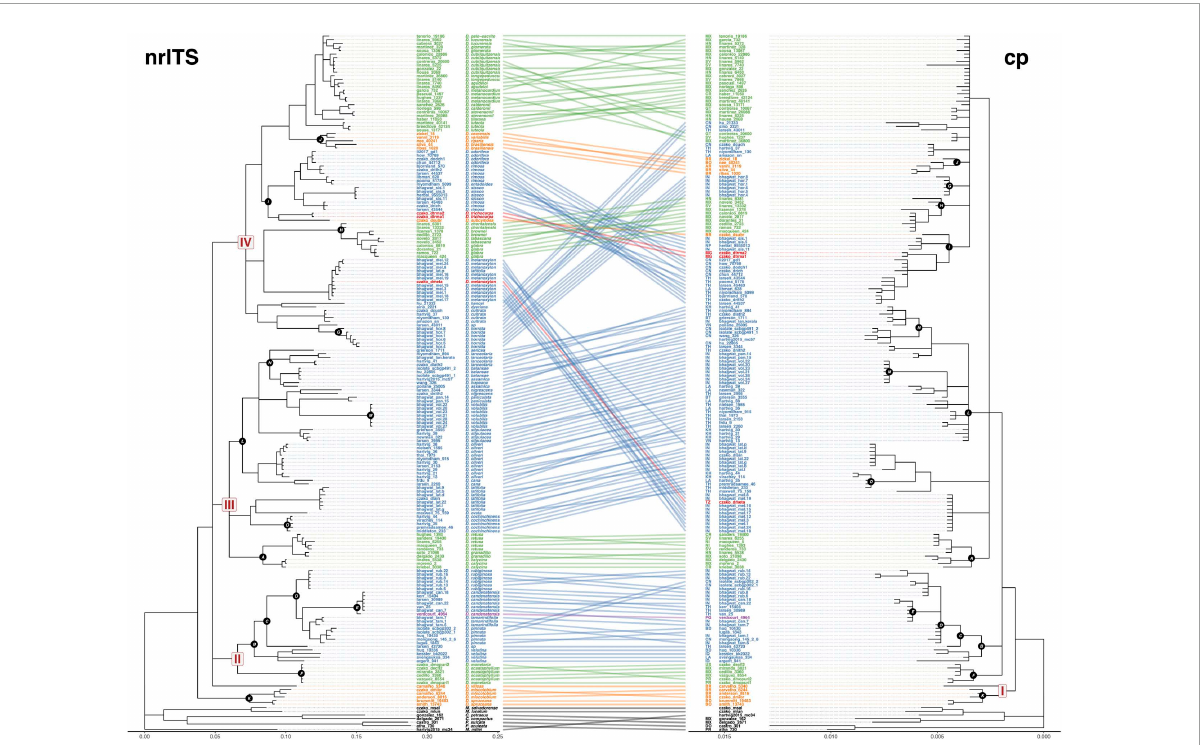
FIGURE4 Tanglegram illustrating the discordance between the ITS gene tree ( nrITS ) and the combined plastid gene tree ( cp ) for Dalbergia . Links connect identical tips, with nodes rotated to minimize link overlap. Links are colored by geographical distribution. Clades that are similar between the two trees are indicated by black circles with white font. Tipuana tipu was eliminated because only the ITS1 sequence was